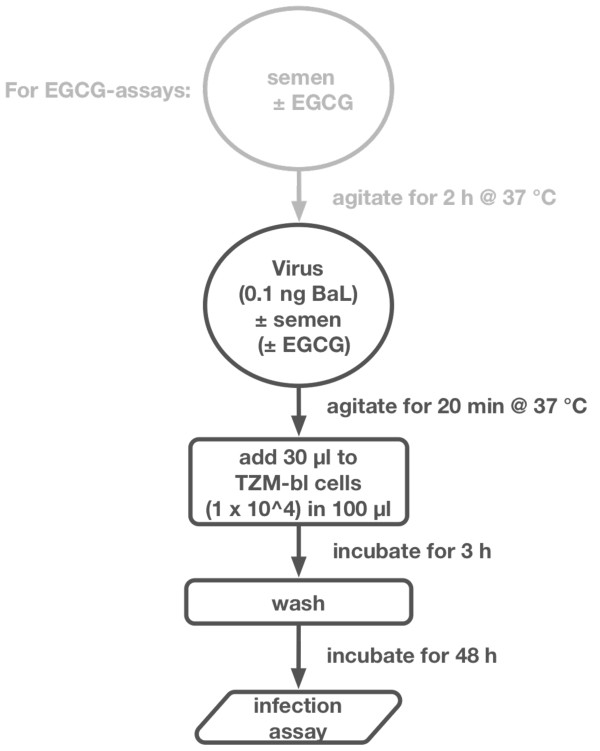
Schematic outline of the experimental procedure.